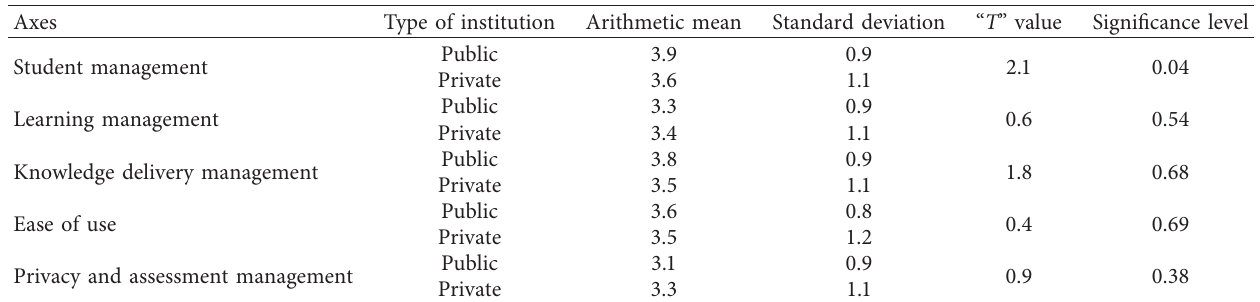
Table 12: Results of the t -test for the quality measure of e-learning programs for students according to the variable of the type of institution. Axes